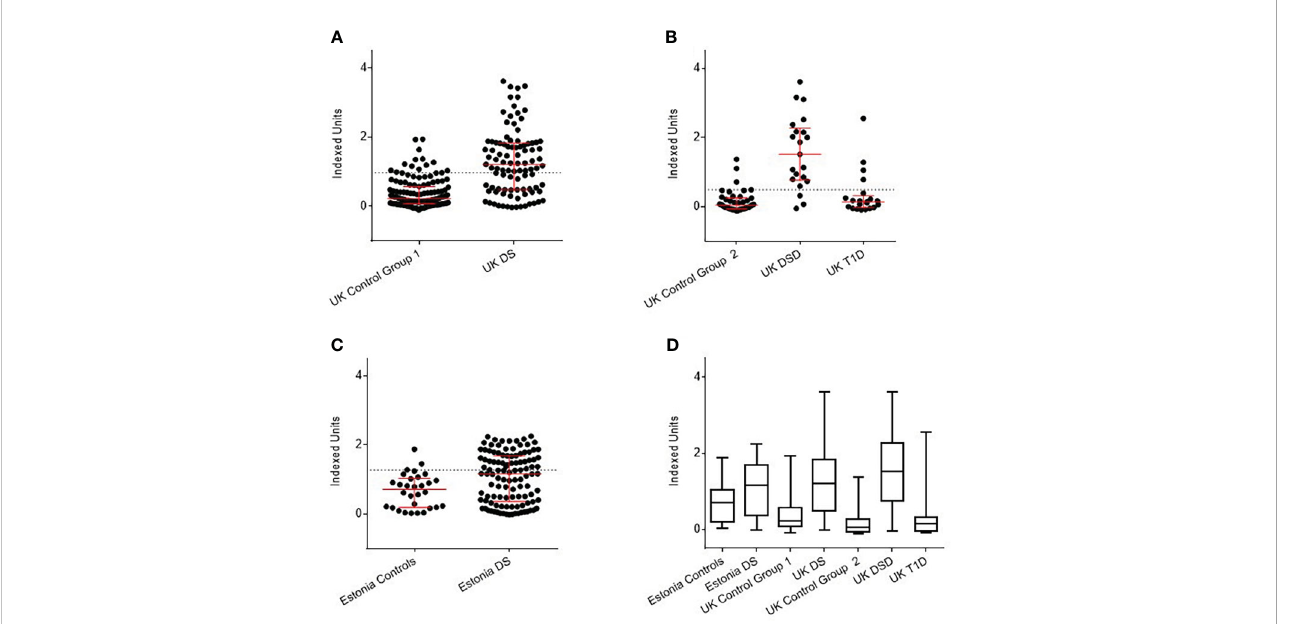
FIGURE 1 Detection of anti-BSA antibodies by radiobinding assay in Down syndrome (DS) populations compared with age, sex, and nationality matched controls. (A) UK DS have increased levels of anti-BSA antibodies compared to controls (p<0.0001). (B) UK DSD with T1D have increased levels of anti-BSA antibodies compared to controls (p<0.0001), those with T1D alone have similar levels of anti-BSA antibodies compared to controls. (C) Estonian DS have increased levels of anti-BSA antibodies compared to controls (p=0.0073). (D) Comparison of anti-BSA antibody titres detected by radiobinding assay between all cohorts. The dotted line represents 90 th centile of age, sex, and nationality matched controls. The red bar represents median and interquartile ranges. Whiskers indicate minimum to maximum. Indexed units were calculated by subtracting the cpm of the negative control and dividing by the cpm of the positive control minus the negative control. DSD, Patients with Down syndrome and T1D, Type 1